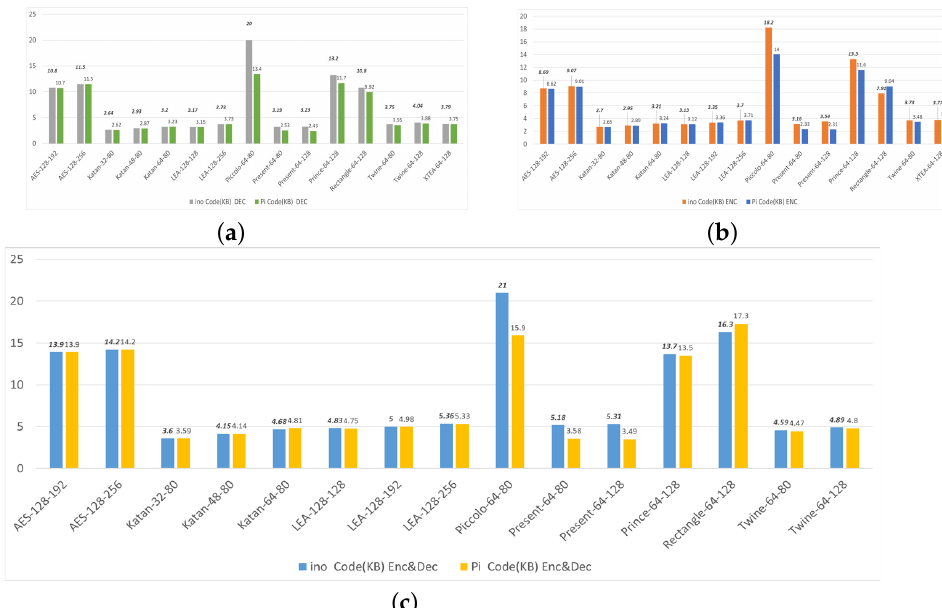
Figure 3. Code size of algorithms used in benchmarking. ( a ) The 10 algorithms of DEC smallest code sizes and 5 of largest. ( b ) The 10 algorithms of smallest ENC code sizes and 5 of largest. ( c ) The